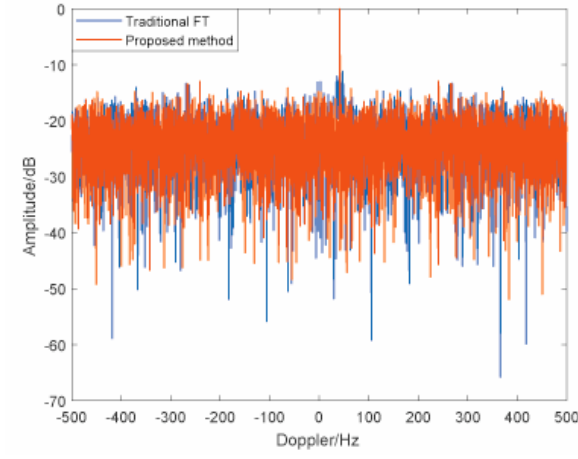
Figure 11. Doppler cross-section of the target.